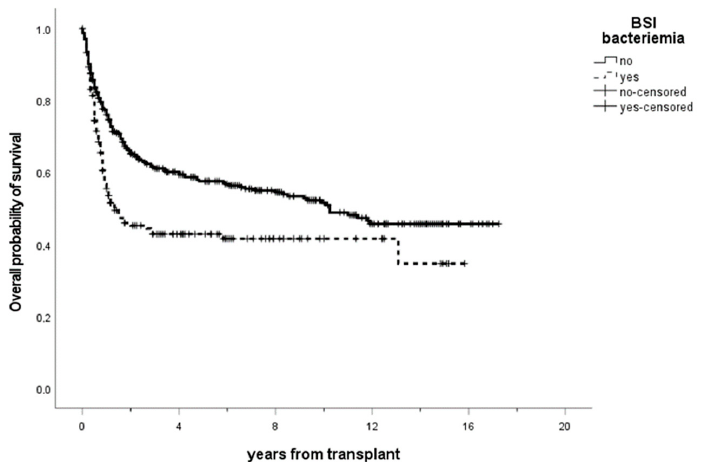
Figure 5. Overall survival of patients receiving allogeneic transplants with a diagnosis of BSI (dashed line) or not (solid line). The 1-year overall survival was 46.1% in BSI positive patients vs. 55.3% in BSI negative patients, with a statistically significant difference ( p < 0.001). Ticks on probability lines indicate dates of censoring at the last follow-up.